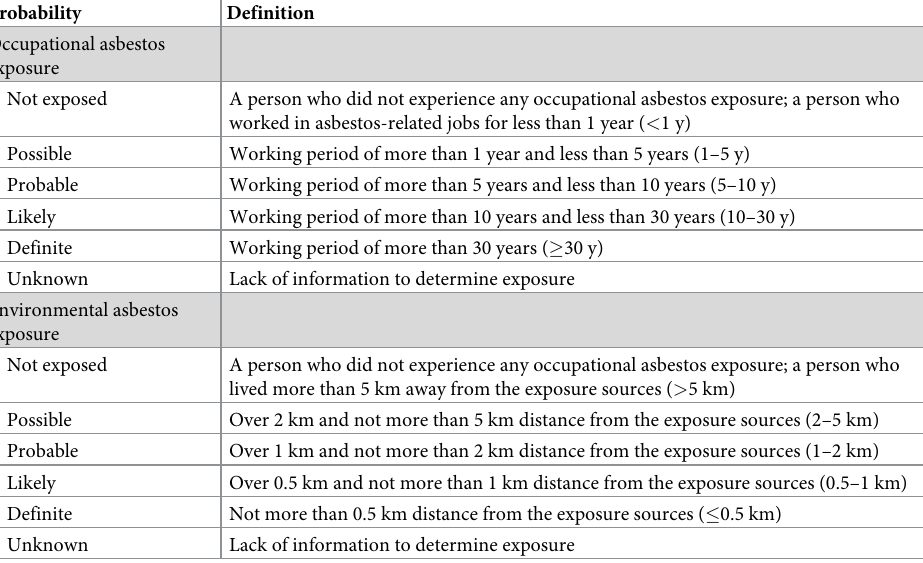
Table 1. Definition of categories of probability for occupational and environmental exposure to